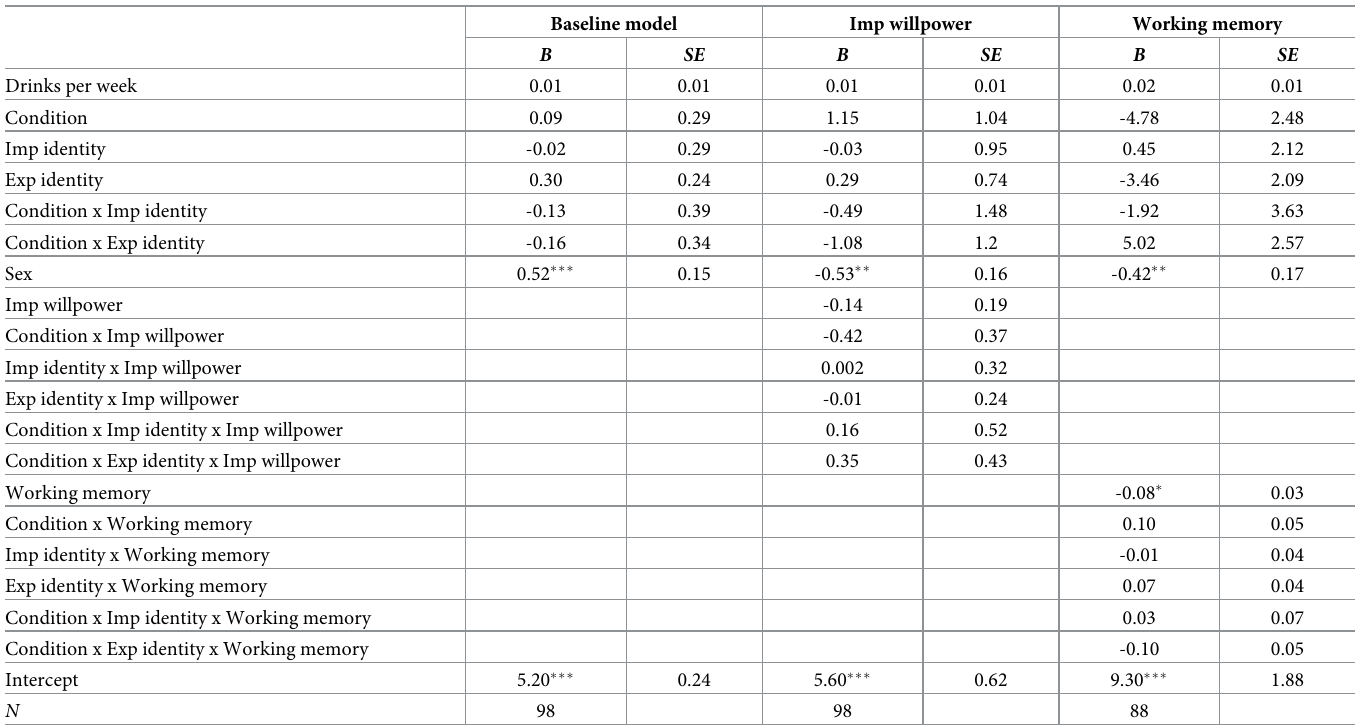
Table 4. Drinking identity